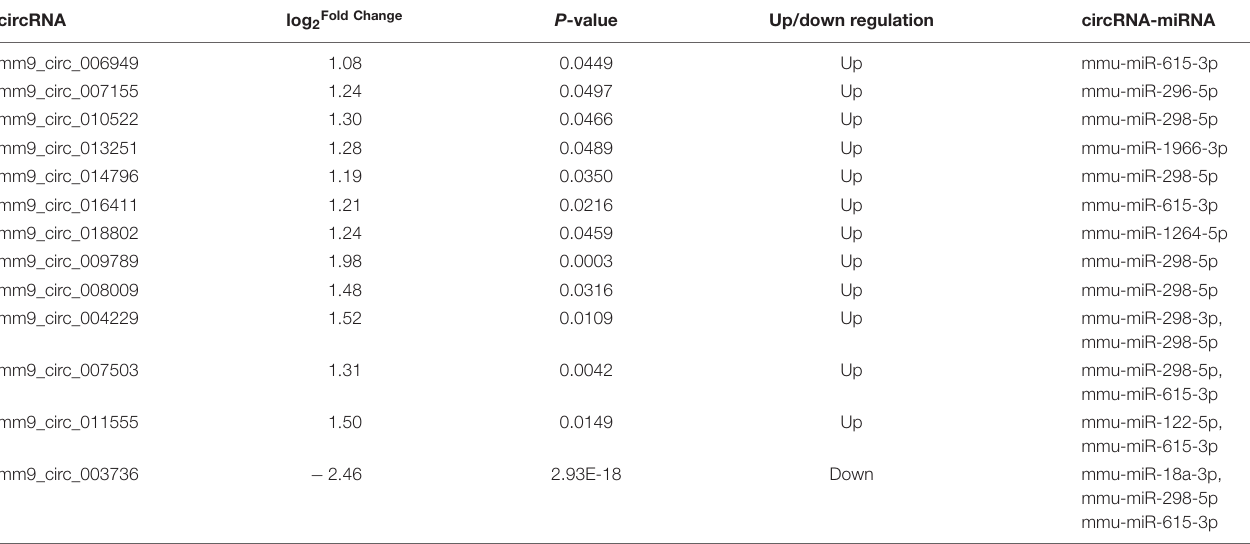
TABLE 3 | DE circRNAs and miRNAs in ceRNA networks under anesthesia/surgery conditions.